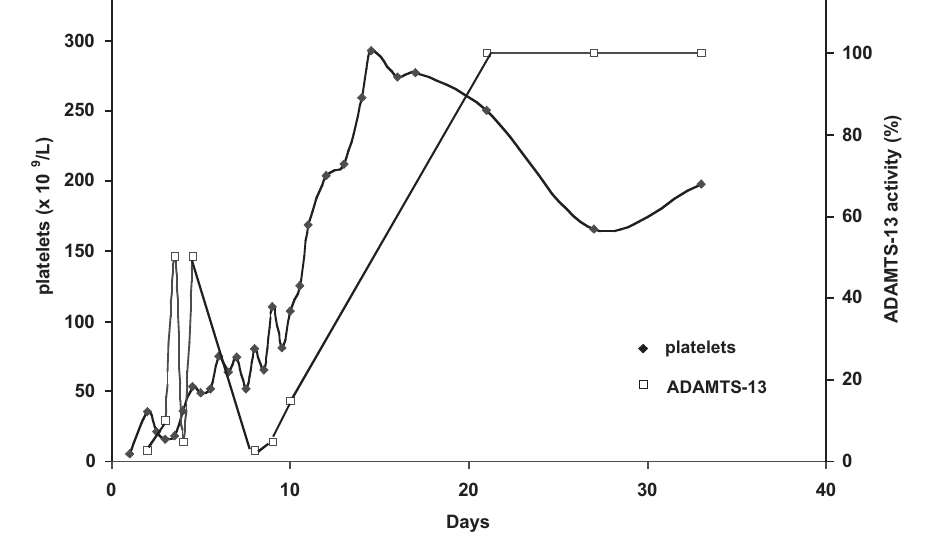
One-year follow-up in a patient with relapsing acquired TTP due to an inhibitory autoanti- body. Quantitative immunoblotting of purified von Willebrand factor substrate degraded by barium chloride-activated ADAMTS-13 in dilu- tions of a normal human plasma pool (NHP) and serial patient plasma samples. Panel A and B constitute separate immunoblotting assays with individual standard curves to adjust for inter-assay